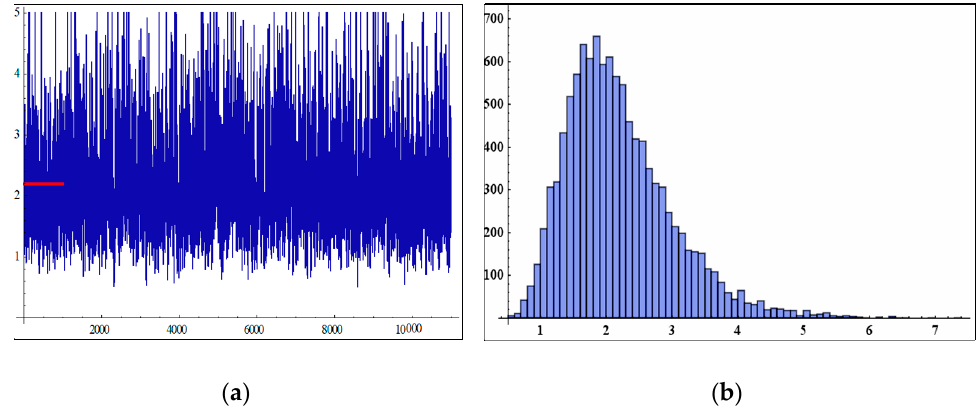
Figure 5. ( a ) Simulation number of δ obtained by MCMC method. ( b ) Histogram of δ obtained by MCMC method.